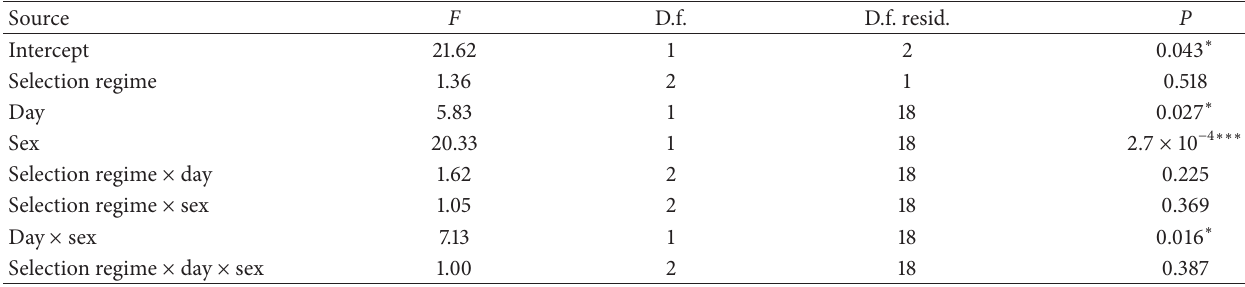
Table2:ANOVAoftransformedproportionofuninfectedprogeny.Themodelincludedthemaineffectsofselectionregime,dayofcollection, and sex of the progeny and main effect interactions. The proportion was transformed by arcsine square root to improve normality of the